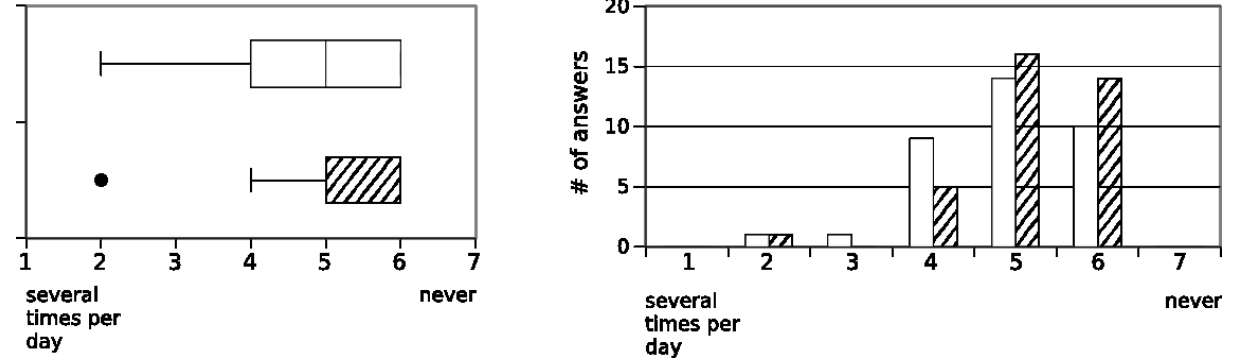
Figure 6. Frequency of using xprompt with patients (36 answers, cross-hatched bars) and alone or with colleagues (35 answers, white